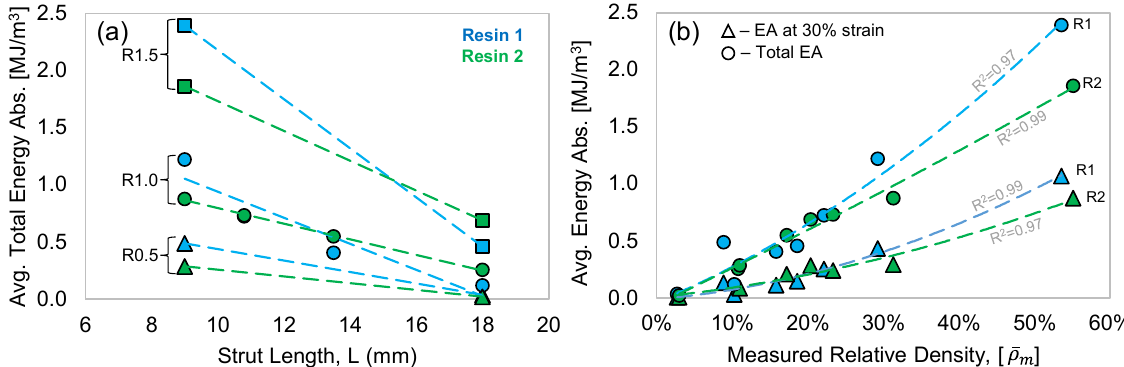
Figure 11. ( a ) The effect or strut length (L) and radius (R) on the average total EA. Dashed lines represent a linear regression fit to the data. ( b ) The average EA with respect to the measured relative density ( ρ ). Regression analysis was used to fit polynomial trendlines to the data.